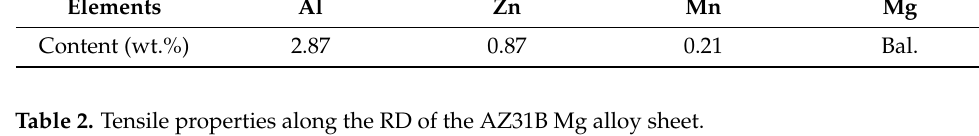
Table 1. Chemical compositions of the AZ31B Mg alloy. Elements